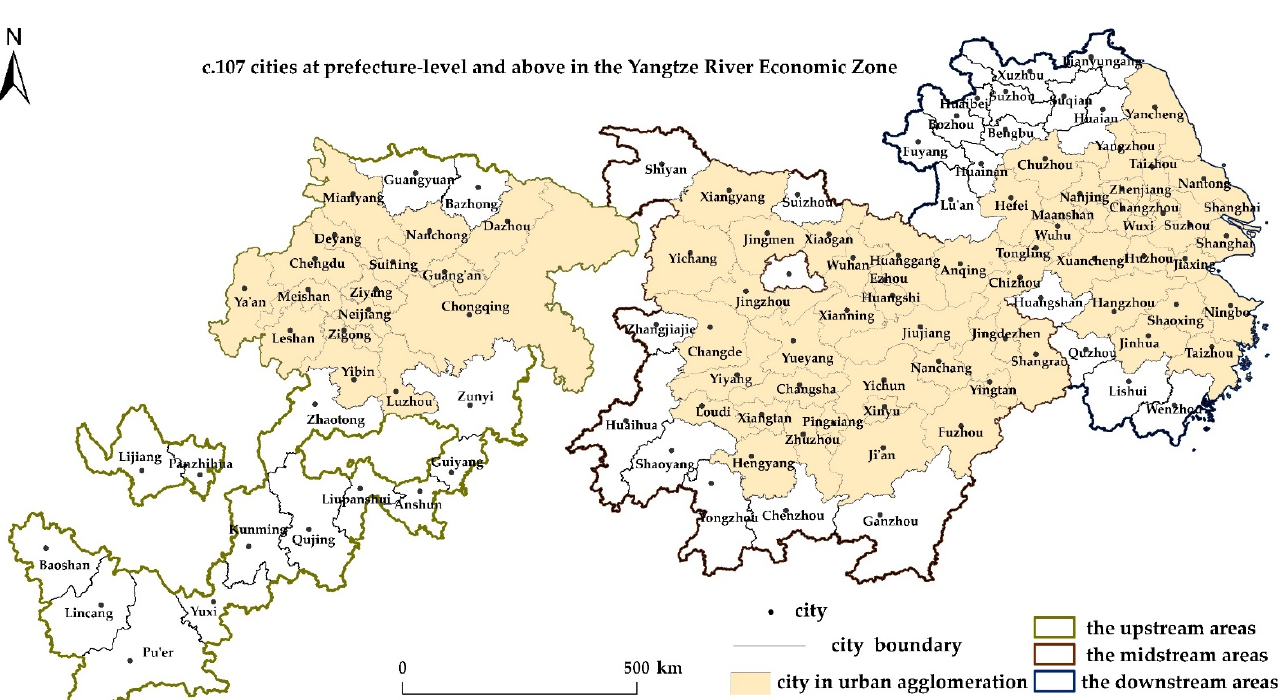
Figure 2. The spatial scope of the Yangtze River Economic Zone in China. ( a ) China; ( b ) the Yangtze River Economic Zone; ( c ) 107 cities at prefecture-level and above in the Yangtze River Economic Zone.